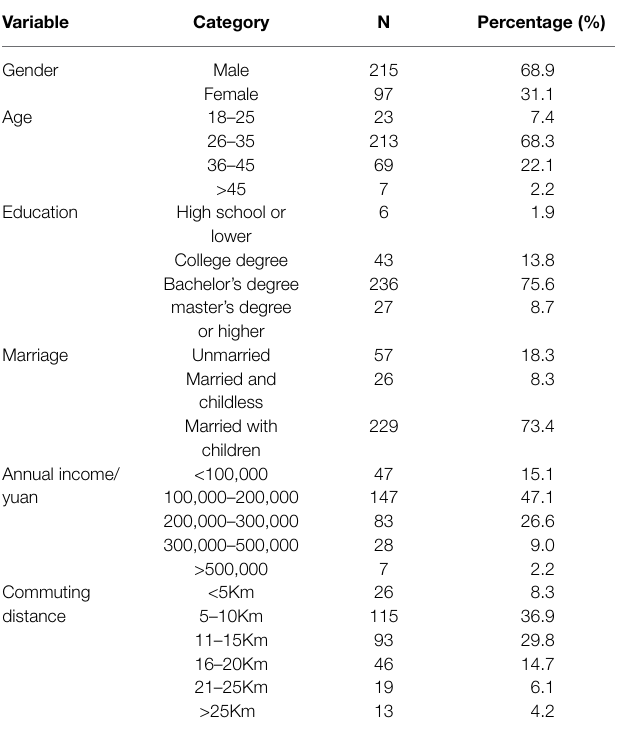
TABLE 2 | Demographics of the research